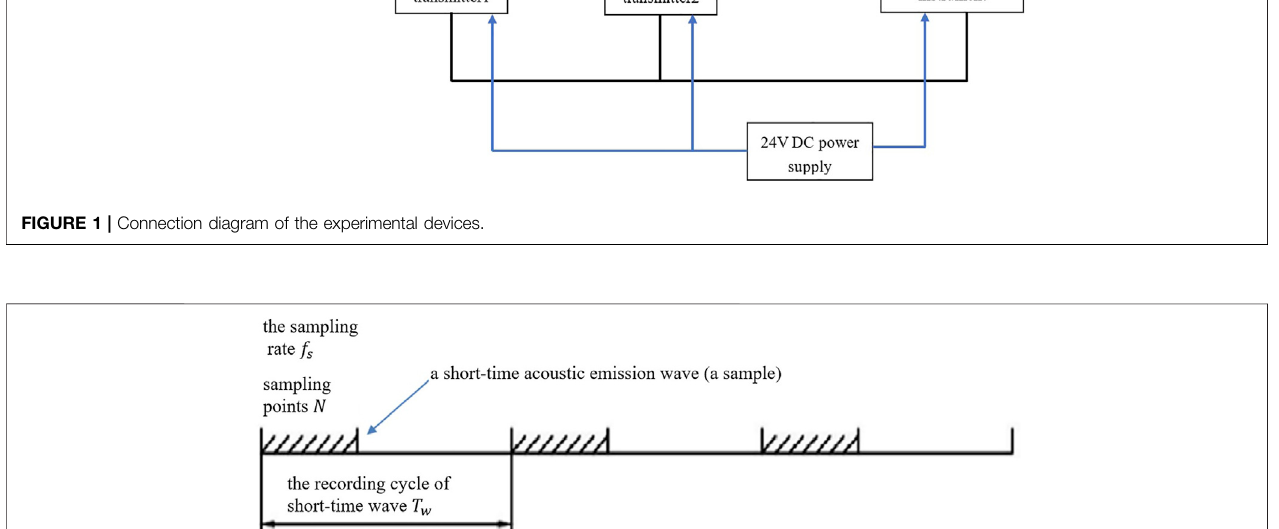
FIGURE 2 | Schematic diagram of the acoustic emission signal acquisition mode.